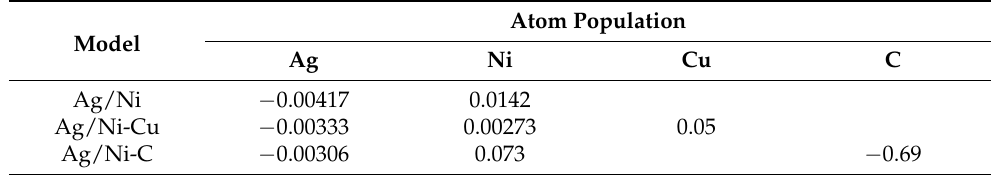
Table 4. Mulliken charge population.